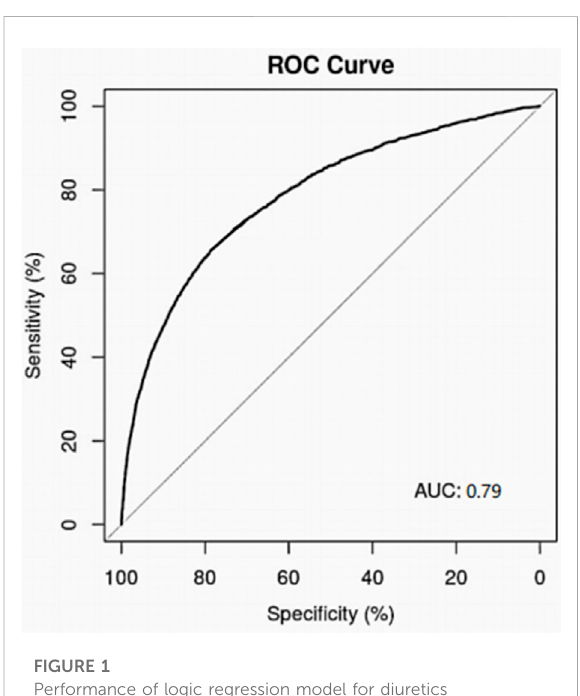
FIGURE 1 Performance of logic regression model for diuretics related